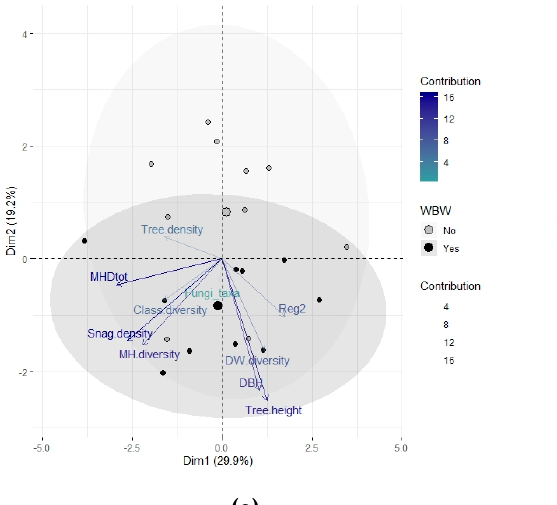
Figure 4. Principal component analysis (PCA) for circular plots ( a ) and transects ( b ). WBW territories (black; “yes”) and non-WBW territories (grey; “no”). The small dots represent each circular plot (a) and transect (b), the big dots represent the center of the ellipse. The longer the arrows, the higher the tendency of the variable towards a group. Dark arrows represent a high contribution of the variable when forming the graphics. MHDtot = total microhabitat density; MH = microhabitat; DW = deadwood; Fungi_taxa = number of fungi taxa; Reg2 = type 2 regeneration; Diameter 10, 20, 30 = density of 10, 20, or 30 cm diameter deadwood; Early decomposition = C and SC classes, Late decomposition = N and D classes. The drawn ellipses had a confidence level of 90%.